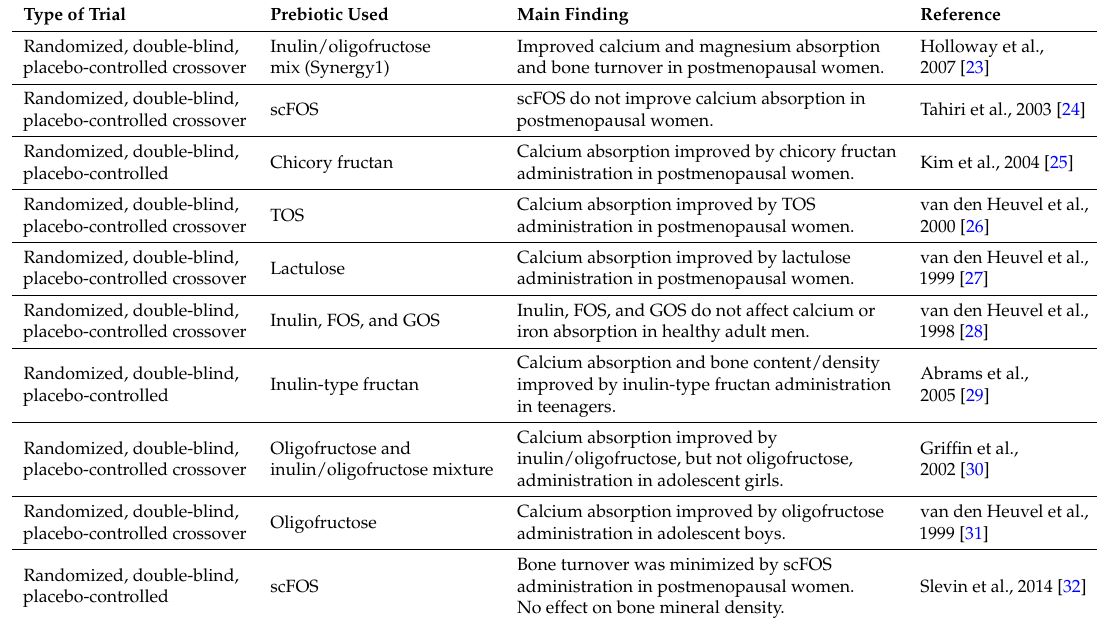
Table 1. Summary of findings from human prebiotic interventions on bone